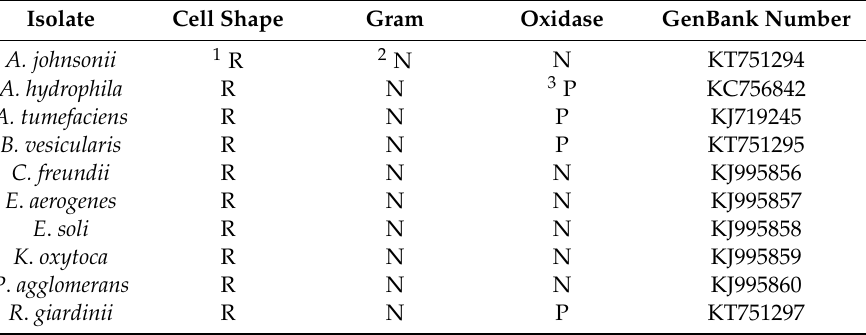
Table 3. Bacterial strains isolated from the processed water